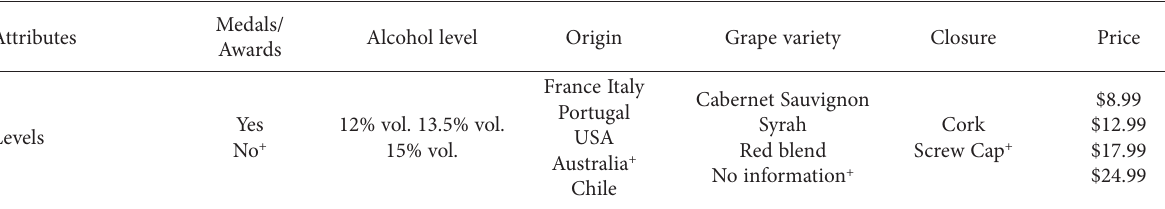
+ reference level on dummy